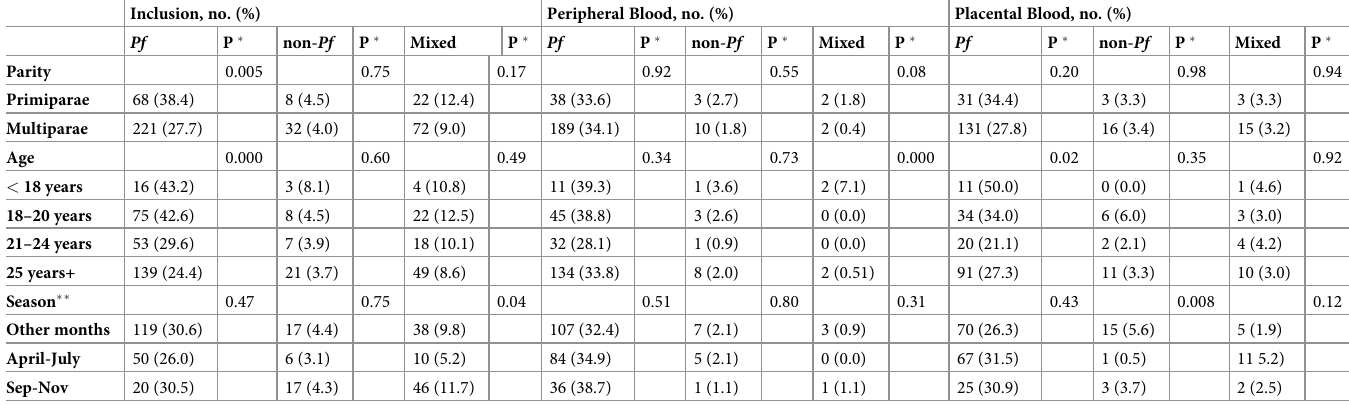
Table 3. Prevalence of Plasmodiumspp . infections during pregnancy according to parity and age of the woman, and the season of sample collection. Inclusion, no.